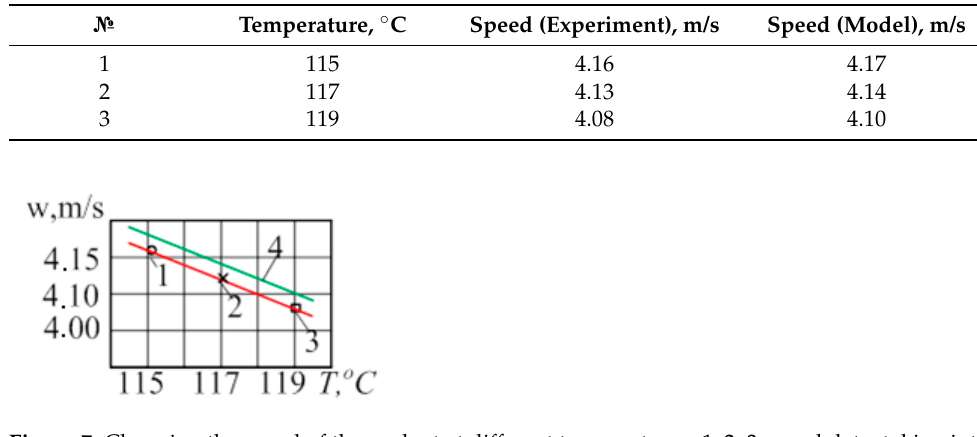
Figure 7. Changing the speed of the coolant at different temperatures: 1, 2, 3 ‐ speed data, taking into account the uncertainty, obtained when 115, 117, 119 ° С , 4 ‐ simulation data.